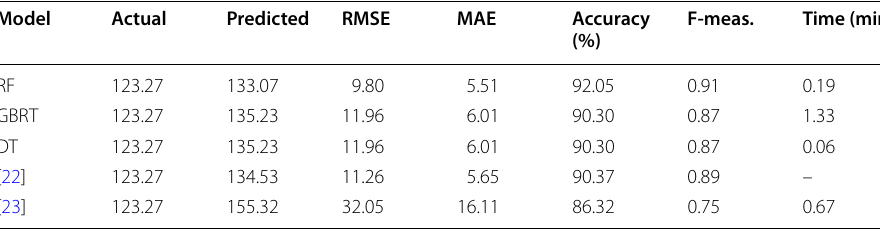
Table 2 Prediction results